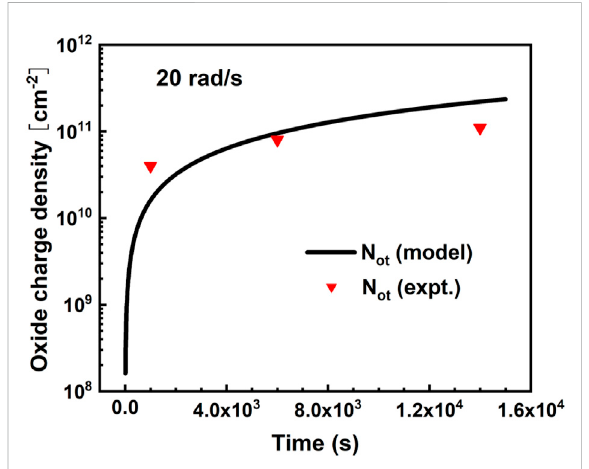
FIGURE 2 Comparison of the evolution of N ot with the experiment for the MOS capacitor with a 200 nm SiO 2 layer under 5 V